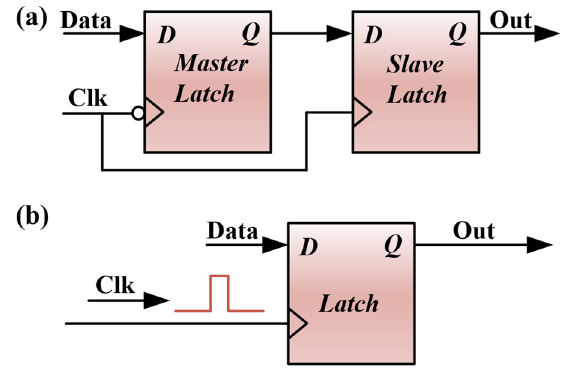
Figure 5. The storage units: ( a ) master–slave register; ( b ) pulsed latch.